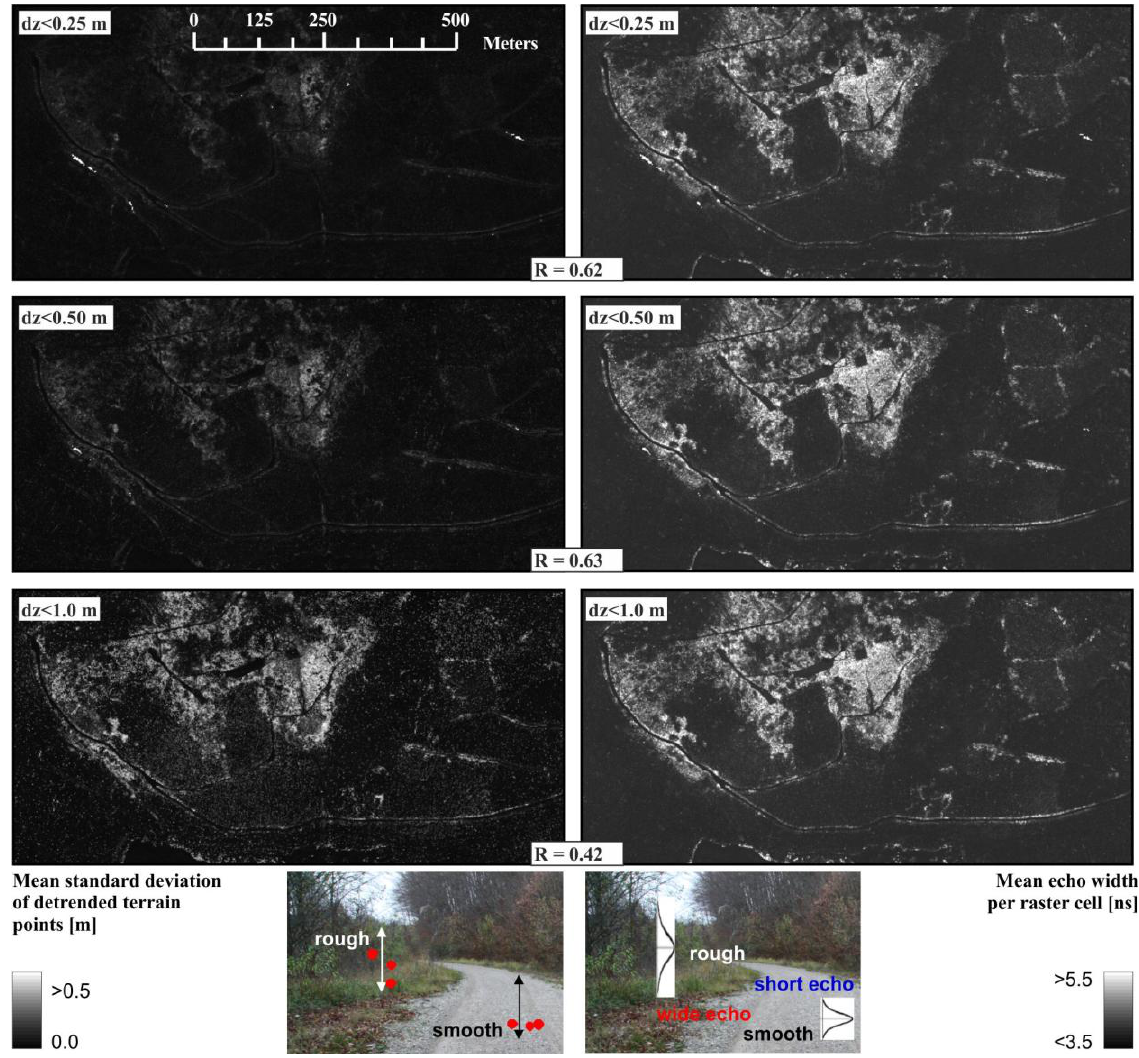
Figure 6. Surface roughness raster layer (1.0 m horizontal resolution) for the test site Wienerwald derived from FWF-ALS data. Left: Mean standard deviation per raster cell of detrended terrain and near terrain echoes for different height thresholds. Right: Mean echo width per raster cell calculated from terrain and near terrain echoes,